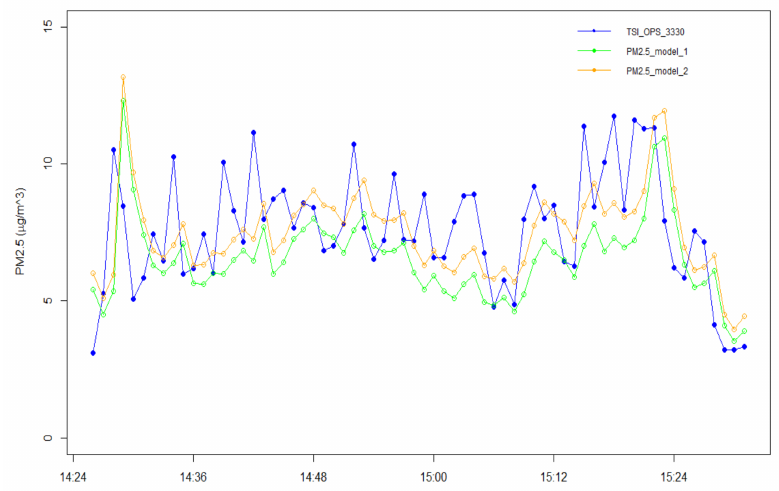
Figure 9. Route followed during the mobile testing in the area of Thessaloniki, Greece on 9 March 2017.